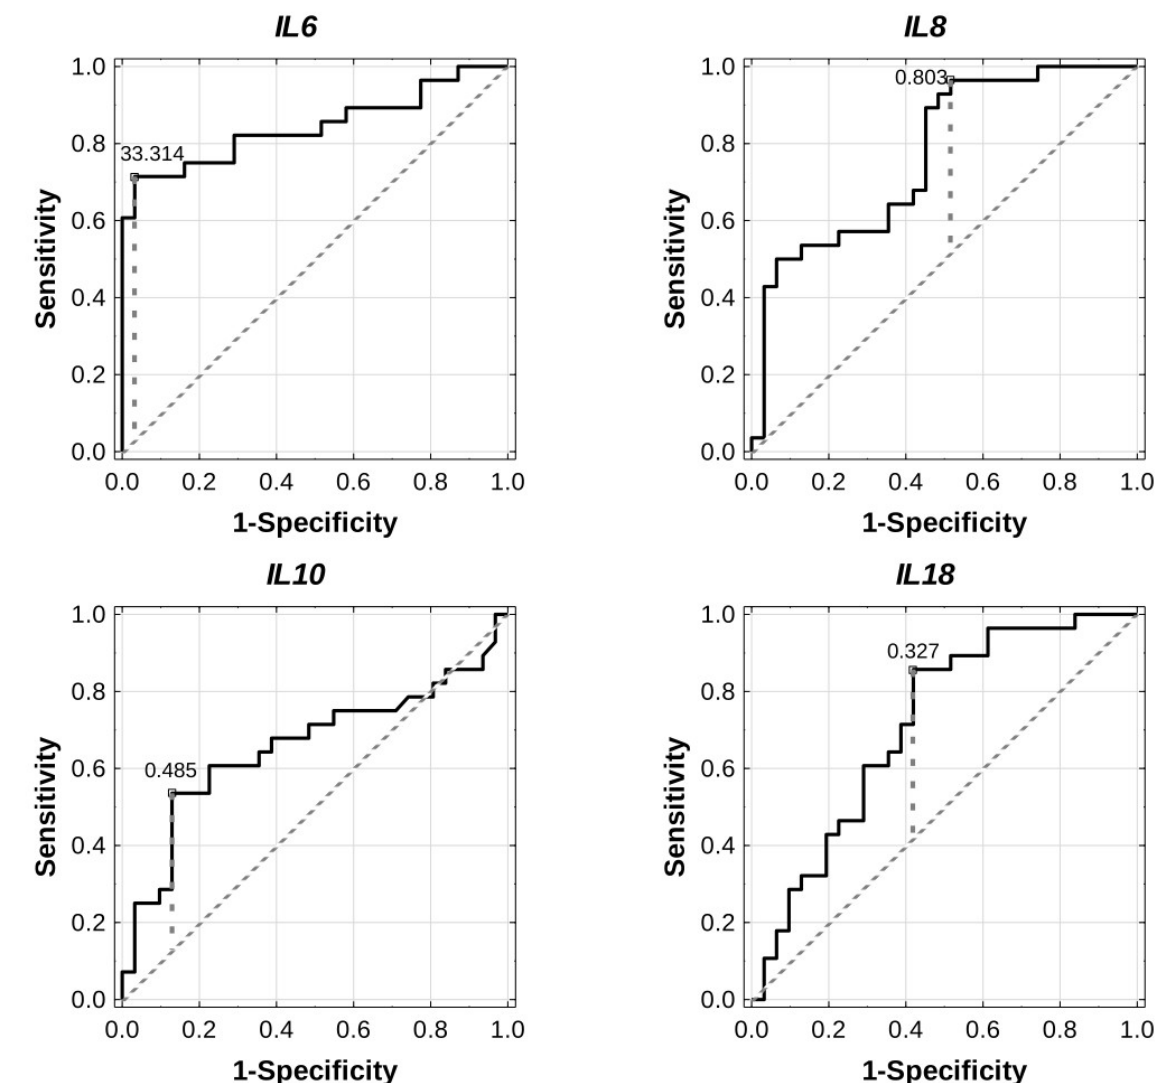
Figure 4. ROC curve analyses for differential expressions of the four investigated genes ( IL6 , IL8 , IL10 ,